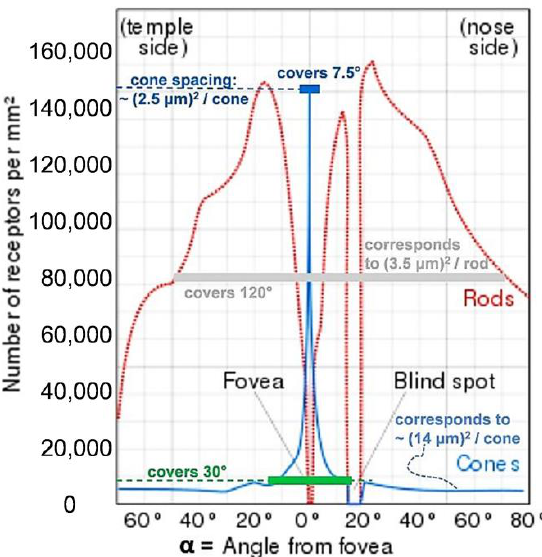
Figure 1. Distribution of rods and cones along a line passing through the fovea and the blind spot of a human eye (p. 5 in